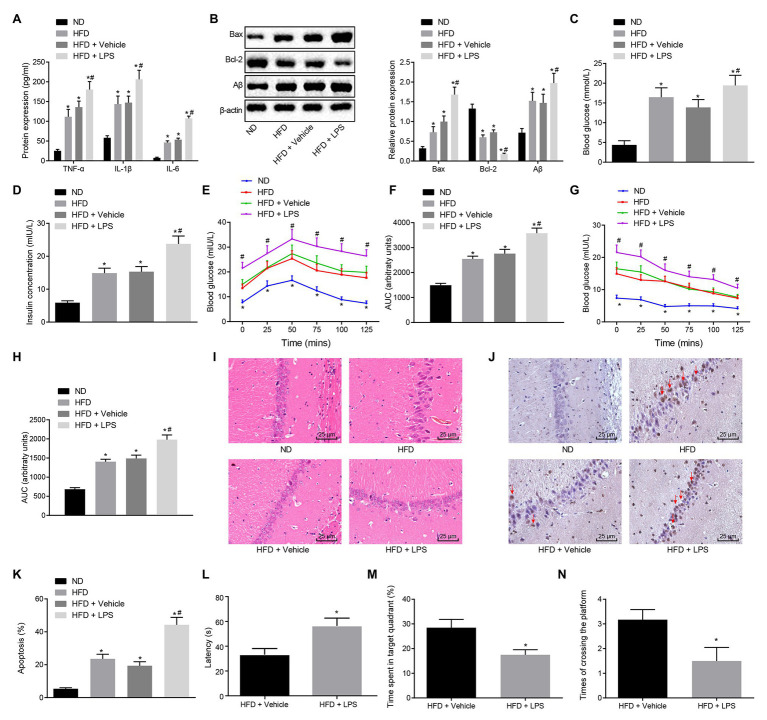
Inflammation, insulin resistance, and cognitive impairment are promoted by exogenous LPS in diabetic mice. (A) Serum levels of inflammatory factors of mice in each group. (B) Western blot analysis of Bcl-2-associated X protein (Bax), Aβ, and Bcl-2 proteins in hippocampal tissues of mice in each group. (C) The fasting blood glucose of mice in each group. (D) Fasting insulin content of mice in each group. (E) Blood glucose levels of mice in each group analyzed by a glucose tolerance test. (F) The area under the curve (AUC) corresponding to E. (G) Blood glucose of mice in each group analyzed by insulin resistance test. (H) The AUC corresponding to the G. (I) HE staining of the pathological tissues of the hippocampal tissues of each group (400×). (J,K) Cell apoptosis in hippocampal tissues of mice in each group measured by TUNEL staining (400×). (L) The latency of mice in each group examined by the Morris water maze experiment. (M) The time ratio of mice in each group staying in the quadrant of the platform. (N) Times that the mice in each group crossed the target platform quadrant. In panel (A–K), *p < 0.05 vs. the mice fed with ND. #p < 0.05 vs. the HFD mice injected with vehicle of LPS. In panel (L–N), *p < 0.05 vs. the HFD mice injected with vehicle of LPS. The results were measurement data and expressed as mean ± standard deviation. Data among multiple groups were compared by one-way ANOVA, followed by Tukey’s post hoc tests. N = 6 for mice following each treatment.